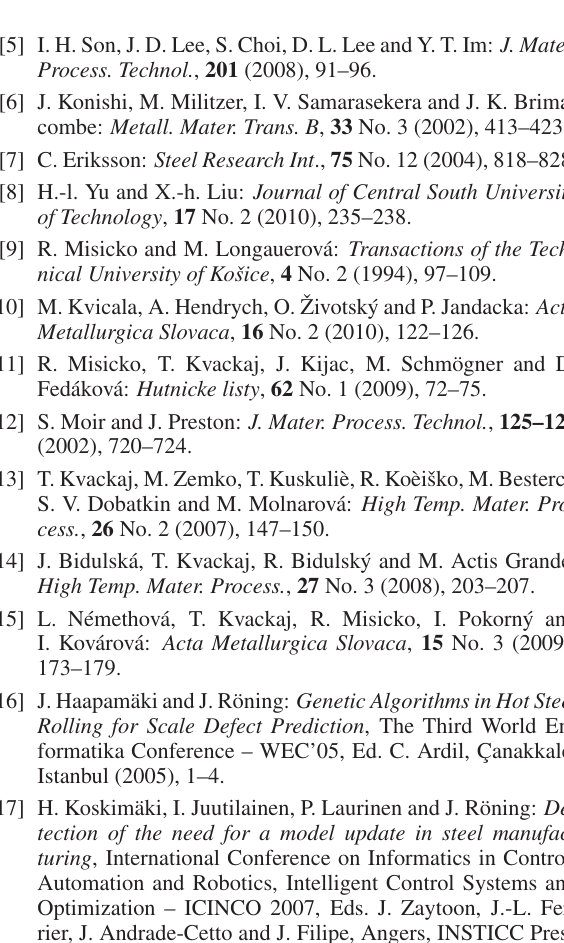
Figure 4. The prediction of U-shaped cracks evolution in continuously cast steel slab.